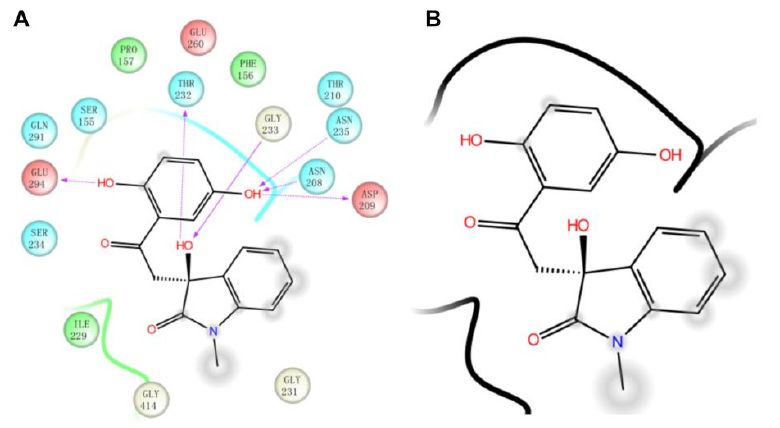
Figure 5. The binding site of HK-II(PDB ID: 2NZT) with compound 4244-3659. ( A ) The two- dimensional binding pattern of the interaction between 4244-3659 and protein. ( B ) 4244-3659 and protein interaction ligand molecular structure